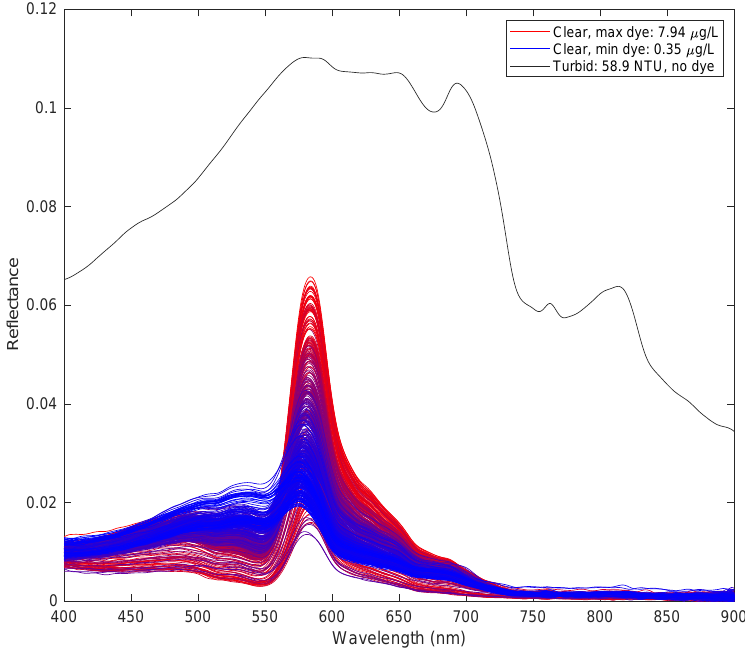
Figure 1. Contrast between field spectra collected from highly turbid water with no dye during the experiment described herein and field spectra from a clear-flowing river in a previous study [10]. The red and blue lines represent field spectra recorded along with dye concentrations during multiple transects across the Kootenai River during the passage of a plume of Rhodamine WT dye. The line color for each individual spectrum is based on the corresponding dye concentration measured in situ, ranging from blue for low, near-background values to a maximum observed concentration of nearly 8 µ g/L. The turbidity of the Kootenai River when these spectra were collected was approximately 2